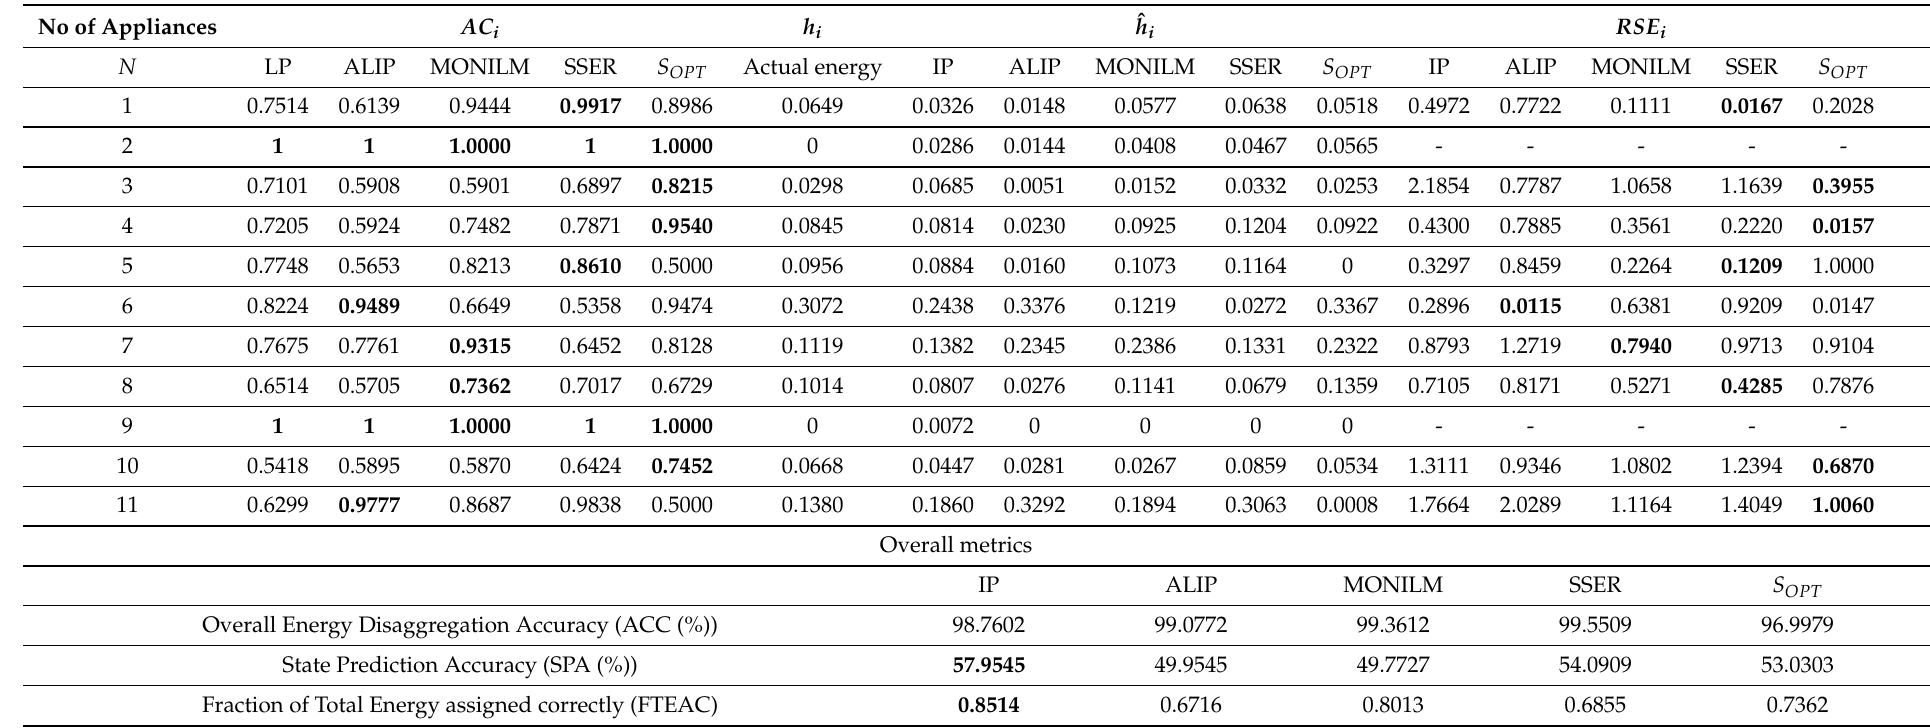
Table 5. Baseline results for instance I 10